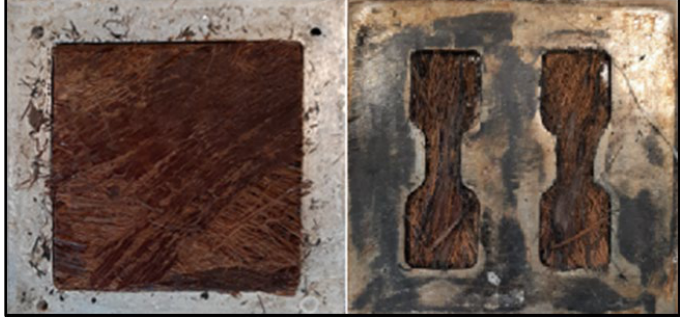
Figure 2. The two types of molds used for the DPSF/PVA composite fabrication.